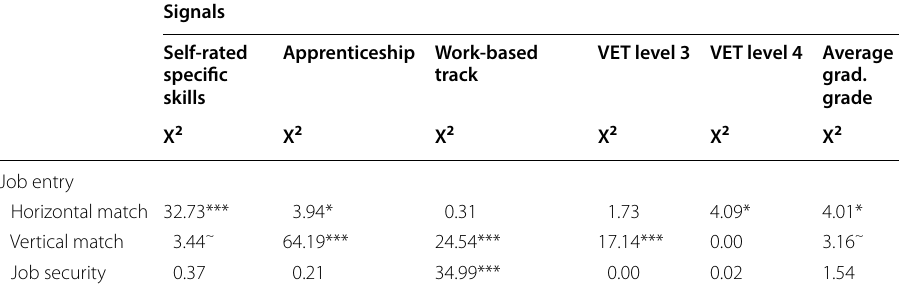
Table 3 Post-estimation Wald tests with Chi square test statistics (X 2 ): Comparing labor market outcomes (N 6014). Source: VET survey 2015 collected by ROA of =